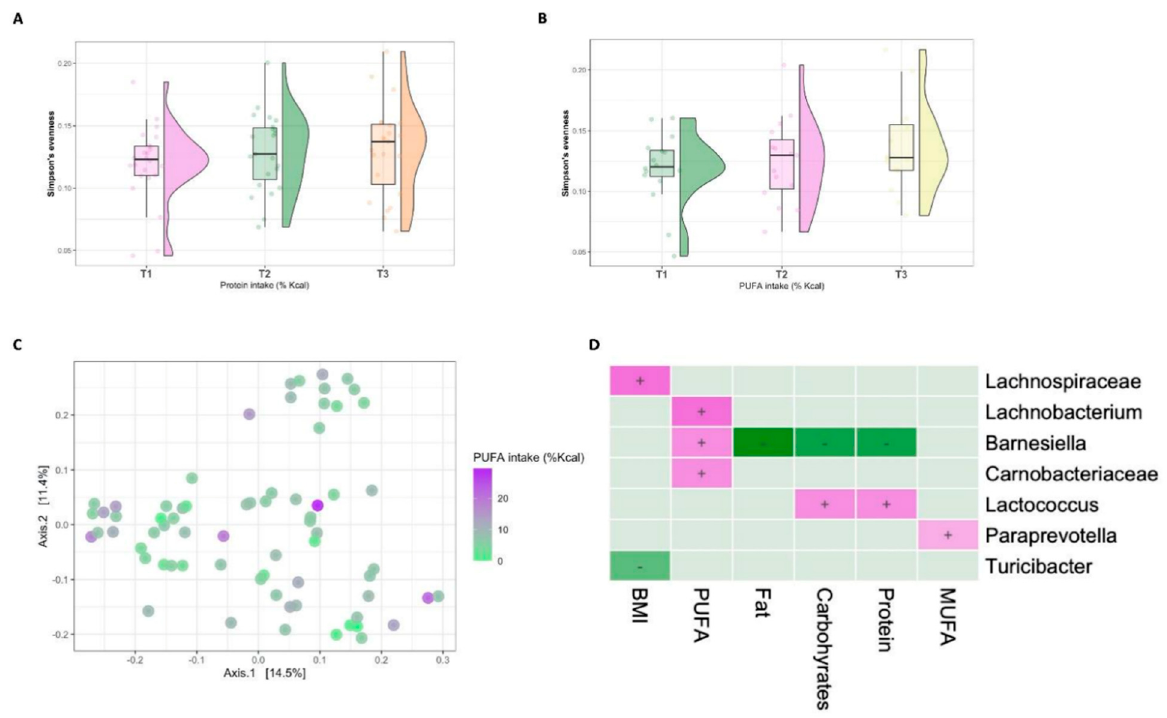
Figure 4. High socioeconomic status and the intestinal microbiome. Box plots of alpha diversity, measured by Simpson’s evenness, according to tertiles intake of ( A ) dietary protein and ( B ) PUFAs (T1 = lowest tertile, T2 = middle tertile, T3 = upper tertile). ( C ) Principal component analysis (PcoA) of Unweighted UniFrac showing the intake of PUFAs among participants from high SES. ( D ) A heatmap of the multivariable model describing the top associations between the independent variables and bacterial features. Positive associations are colored in purple, while inverse associations are colored in green. The color gradient represents the strength of the association observed, with darker colors representing stronger associations. The effect size was calculated by the following formula: ( − log(qval)*SIGN